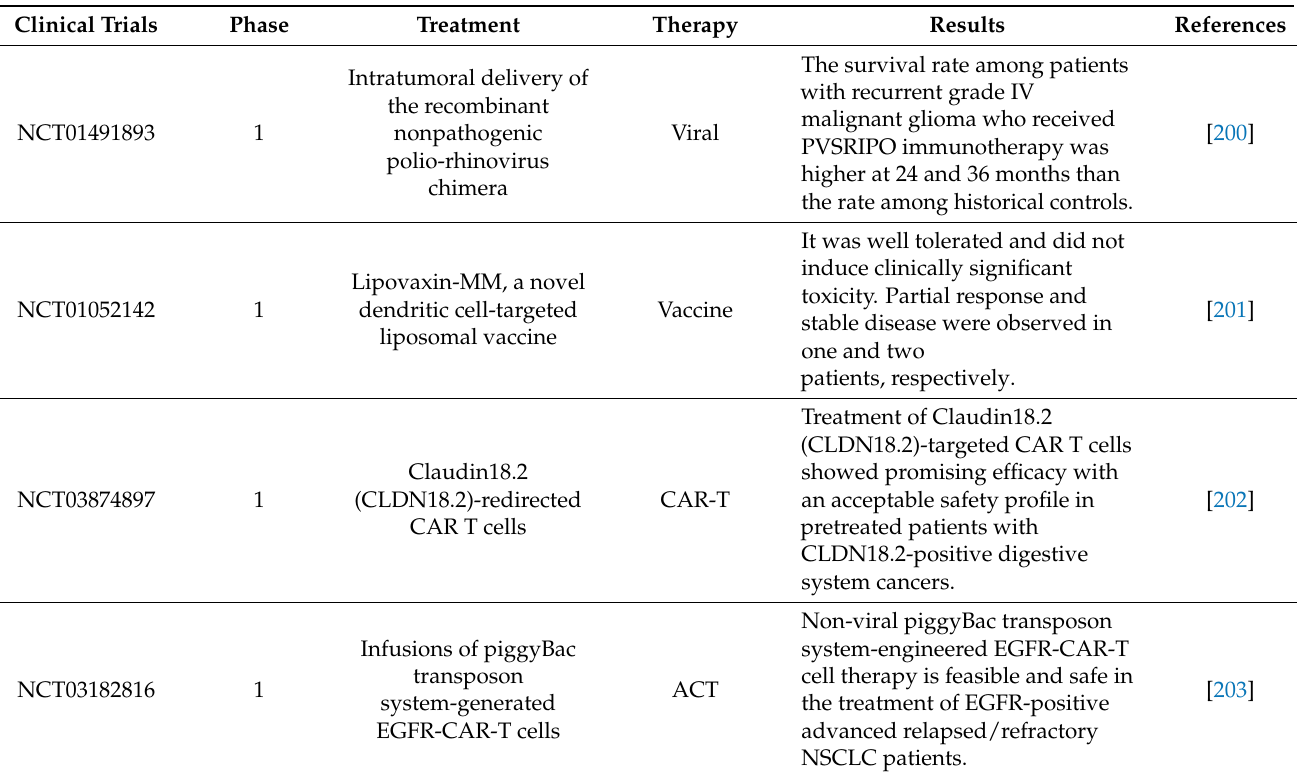
Table 5. Strategies for immunotherapy and treatment delivery. Clinical